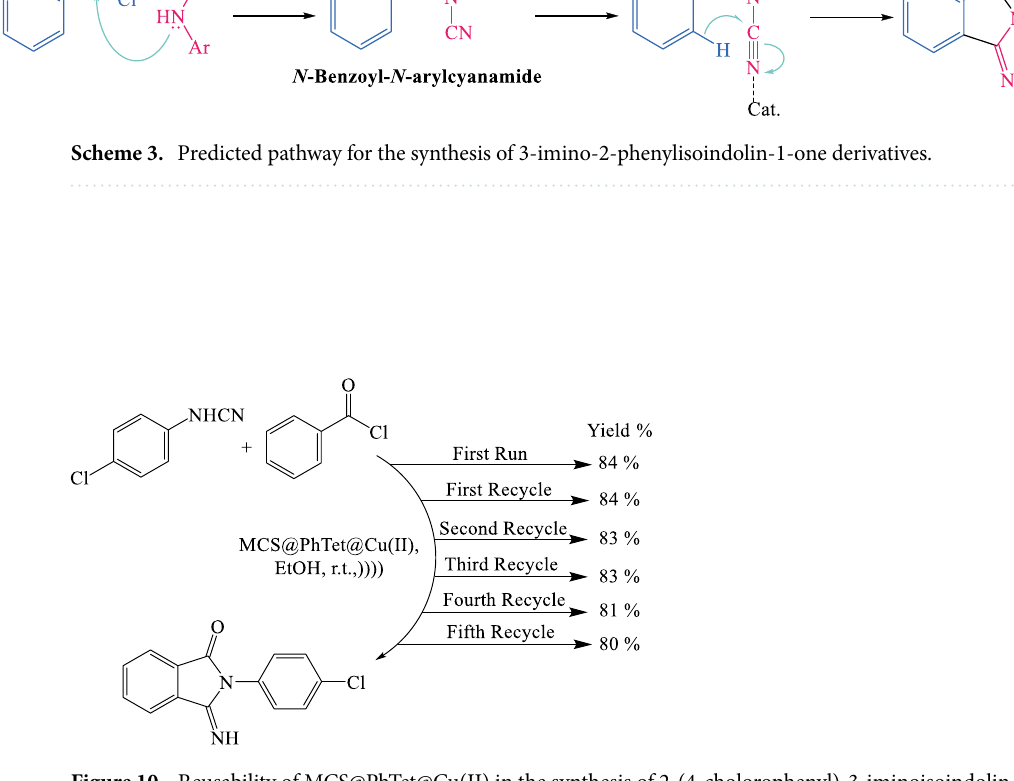
Figure 10. Reusability of MCS@PhTet@Cu(II) in the synthesis of 2-(4-cholorophenyl)-3-iminoisoindolin-1-